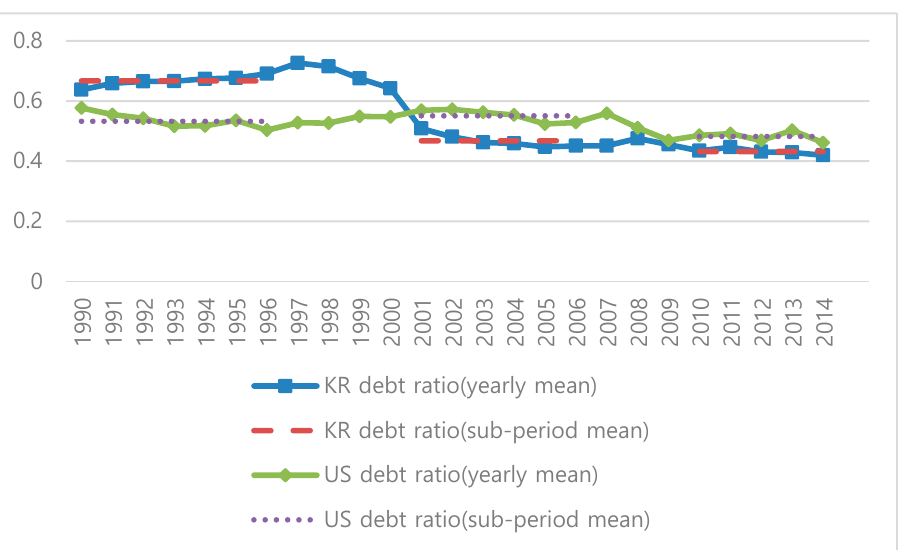
Figure 2. Comparison of debt ratio. Table 3. Comparison of debt ratio by regression.